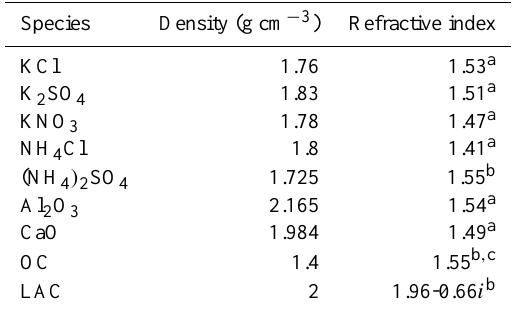
Table 1. Density and refractive index for the species used to model aerosol optical and physical properties. OC and LAC correspond to organic carbon and light absorbing carbon, respectively. Refractive indices correspond to a wavelength of